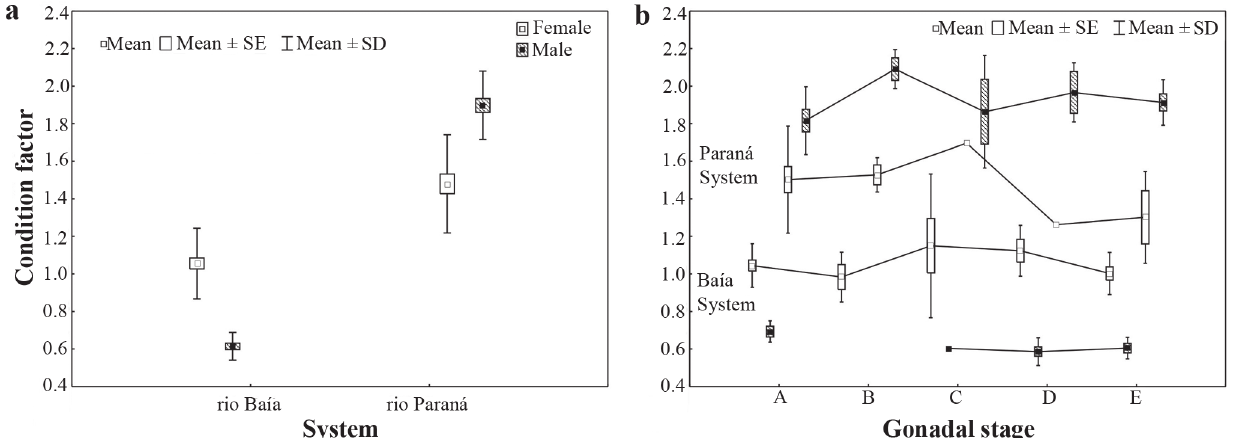
Fig. 6. Monthly variations in the values of condition factor for both sexes. ( a ) Condition factor in the different systems; ( b ) different system and different gonadal development. Gonadal maturation stages: A = immature, B = resting, C = maturing, D = mature, E =